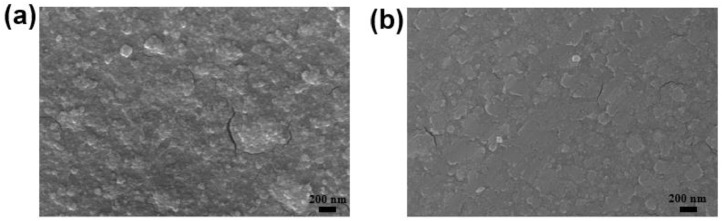
SEM images of the WO3 film prepared by (a) CA and (b) PA.